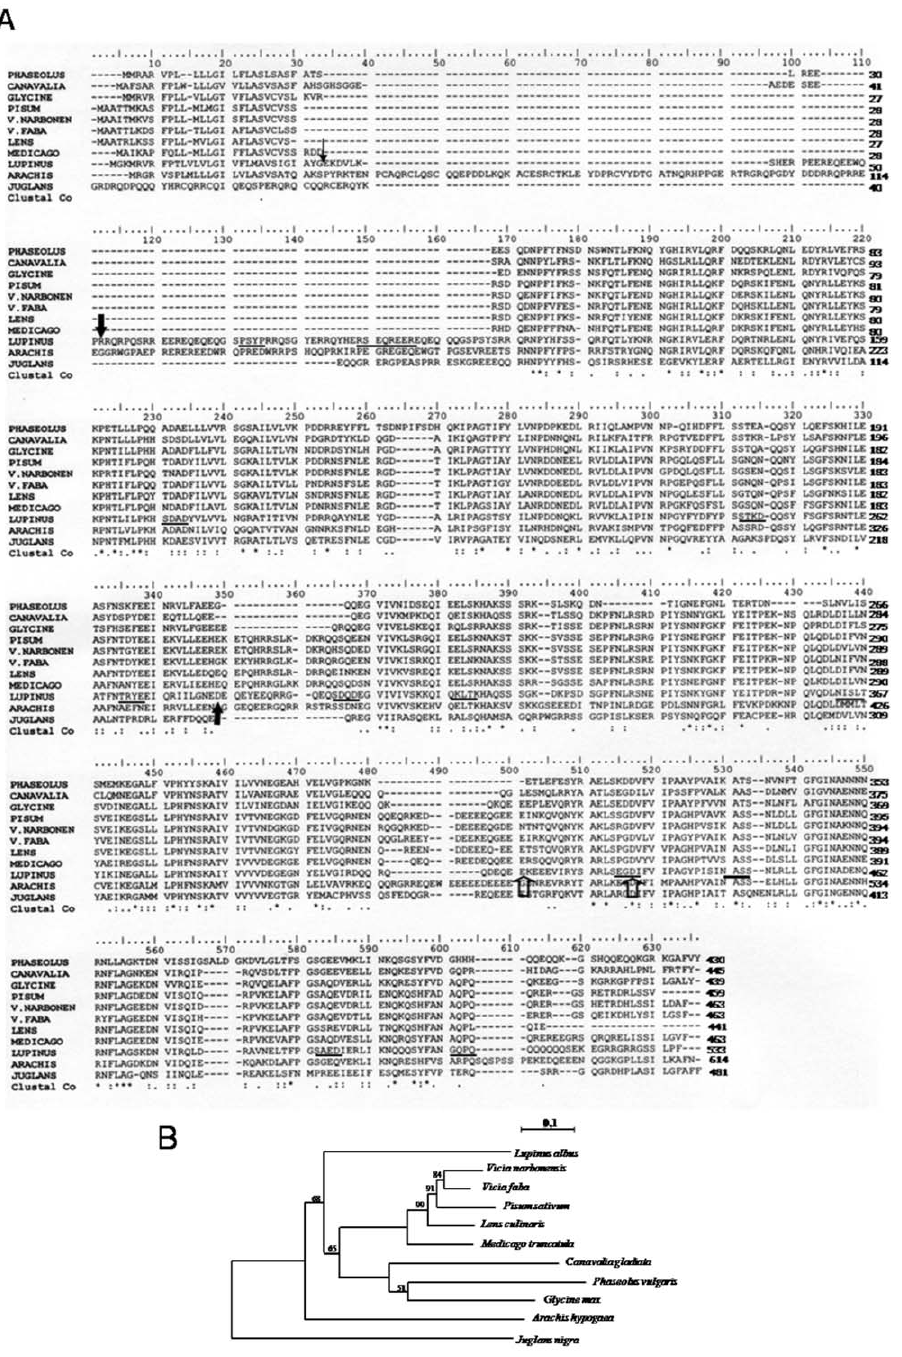
Figure 1. Comparison of b -conglutin precursor with the vicilins from other legume species. (A) Multiple sequence alignment of predicted amino acid sequences of Lupinus albus b -conglutin precursor with other legume vicilins. In the b -conglutin sequence, the small arrowhead designates the putative cleavage of the signal peptide; larger closed arrowheads denote the N- and C- terminals of blad; larger open arrowheads denote the beginning and the end of the UIM; potential N -glycosylation and phosphorylation sites are underlined by thick and thin lines, respectively. The asterisks indicate that the residues in column are identical in all sequences in the alignment; colons indicate conservative substitutions; full stops mean that semi-conserved substitutions are observed. Hyphens are inserted to optimize the alignments. LUPINUS- Lupinus albus ; V.FABA- Vicia faba ; LENS- Lens culinaris ; PISUM- Pisum sativum ; V.NARBORENSIS- Vicia narborensis , GLYCINE- Glycine max ; PHASEOLUS- Phaseolus vulgaris ; CANAVALIA- Canavalia gladiata ; MEDICAGO- Medicago truncatula ; JUGLANS- Juglans nigra ; ARACHIS- Arachis hypogaea . (B) Phylogram of vicilin-like proteins with high homology to b -conglutin from Lupinus albus . The following proteins were included in the phylogenetic analyses: Vicia faba (vicilin precursor, CAA68525), Lens culinaris (allergen Len c, CAD87731), Pisum sativum (vicilin, CAA32239), Vicia narbonensis (vicilin precursor, CAA96514), Glycine max (alpha’ subunit of beta-conglycinin, BAE02726), Phaseolus vulgaris (phaseolin, AAC04316), Canavalia gladiata (canavalin, CAA33172), Medicago truncatula (cupin, ABD28364), Juglans nigra (vicilin, AAM54366) and Arachis hypogaea (allergen Ara h 1, P43237).